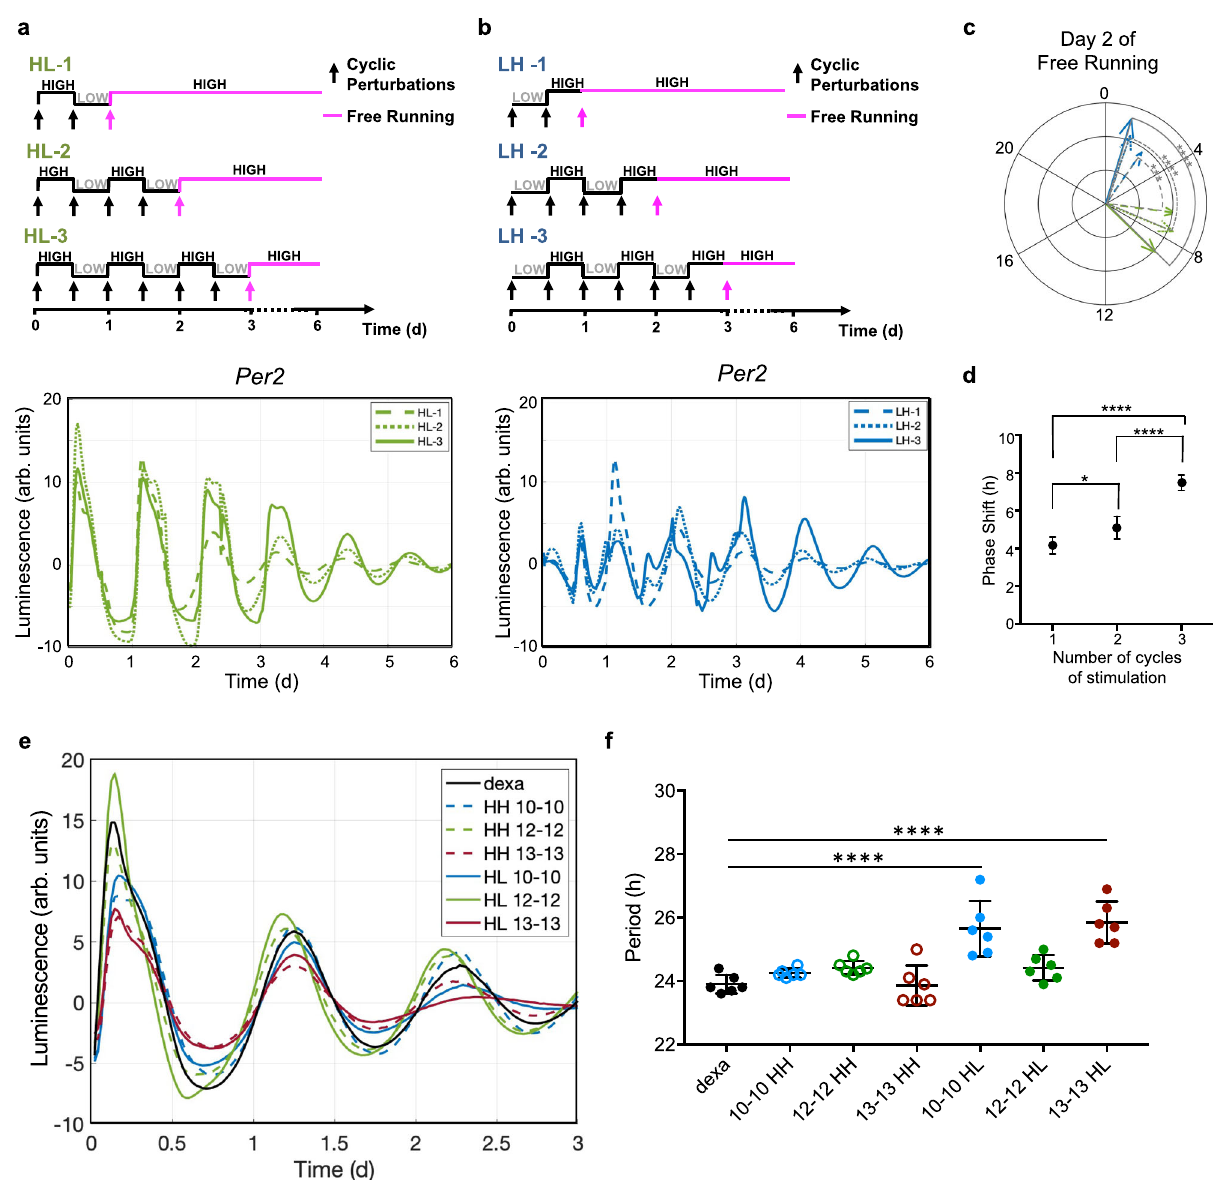
Fig. 3 Metabolic behavior of cyclic day and night by micro fl uidic technology. a Schematic representation of feeding-fasting (HL) behavior imposed for 1, 2, or 3 days and followed by a FR condition (top); baseline-subtracted Per2::Luc bioluminescence patterns of Per2::Luc mouse fi broblasts in HL-1,2,3, acquired at an interval of 30 min (bottom). Data are represented as mean, N = 3 for each group. b Schematic representation of fasting-feeding (LH) behavior imposed for 1, 2, or 3 days and followed by a FR condition (top); baseline-subtracted Per2::Luc bioluminescence patterns of Per2::Luc mouse fi broblasts in LH-1,2,3, acquired at an interval of 30 min (bottom). Data are represented as mean, N = 3 for each group. c Polar representation of the relative temporal position of the acrophases of HL-1,2,3 and LH-1,2,3 pro fi les at day 2 of FR, N = 6 for each group; the arrow length (radial axis) indicates the value of amplitude, the angular position indicates the position of acrophase. The standard deviations of the acrophases in each condition are 0.52 h (HL-1), 1.04 h (HL-2), 0.52 h (HL-3), 1.97 h (LH-1), 1.57 h (LH-2) 0.52 h (LH-3); *** P = 0.0005, **** P < 0.0001 two-sided t -test. d Comparison of the phase shift between the HL and LH conditions imposed for 1, 2, or 3 days, after 48 h of FR. Data are represented as mean ± s.d., N = 6 for each group. * P = 0.0124, **** P < 0.0001 one-way ANOVA with Tukey ’ s multiple comparisons test. e Baseline-subtracted Per2::Luc bioluminescence rhythms during FR after 3 cycles of stimulation of HL and HH imposed with different time windows (10:10 h, 12:12 h, 13:13 h). The luminescence was acquired from t = 0 to t = 3 d at intervals of 30 min; data shown are mean baseline-subtracted luminescence signal, N = 4 – 6 for each condition. f Period comparison among the experimental conditions implemented in e , **** P < 0.0001, using one-way ANOVA with Tukey ’ s multiple comparisons test. Source data are available as a Source Data fi